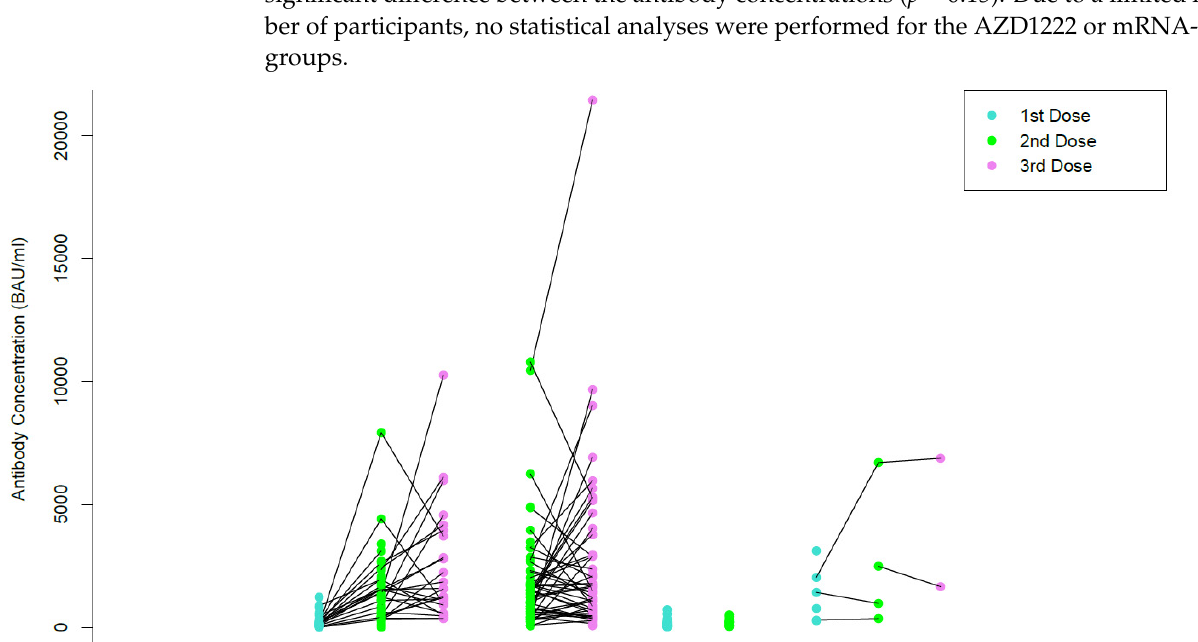
Figure 1. Antibody concentration after the first, second, and third doses . The upper green line of 4893.9 BAU/mL is the highest antibody concentration prior to a known breakthrough infection. The lower orange line of 2057.7 BAU/mL is the aver- age of antibody concentrations in seven infections confirmed by WGS. The percentages shown in green represent the percentage of antibody concentration that is above 4893.9 BAU/mL per each dose of each vaccine type, whereas the percentages in orange represent those above 2057.7 BAU/mL.